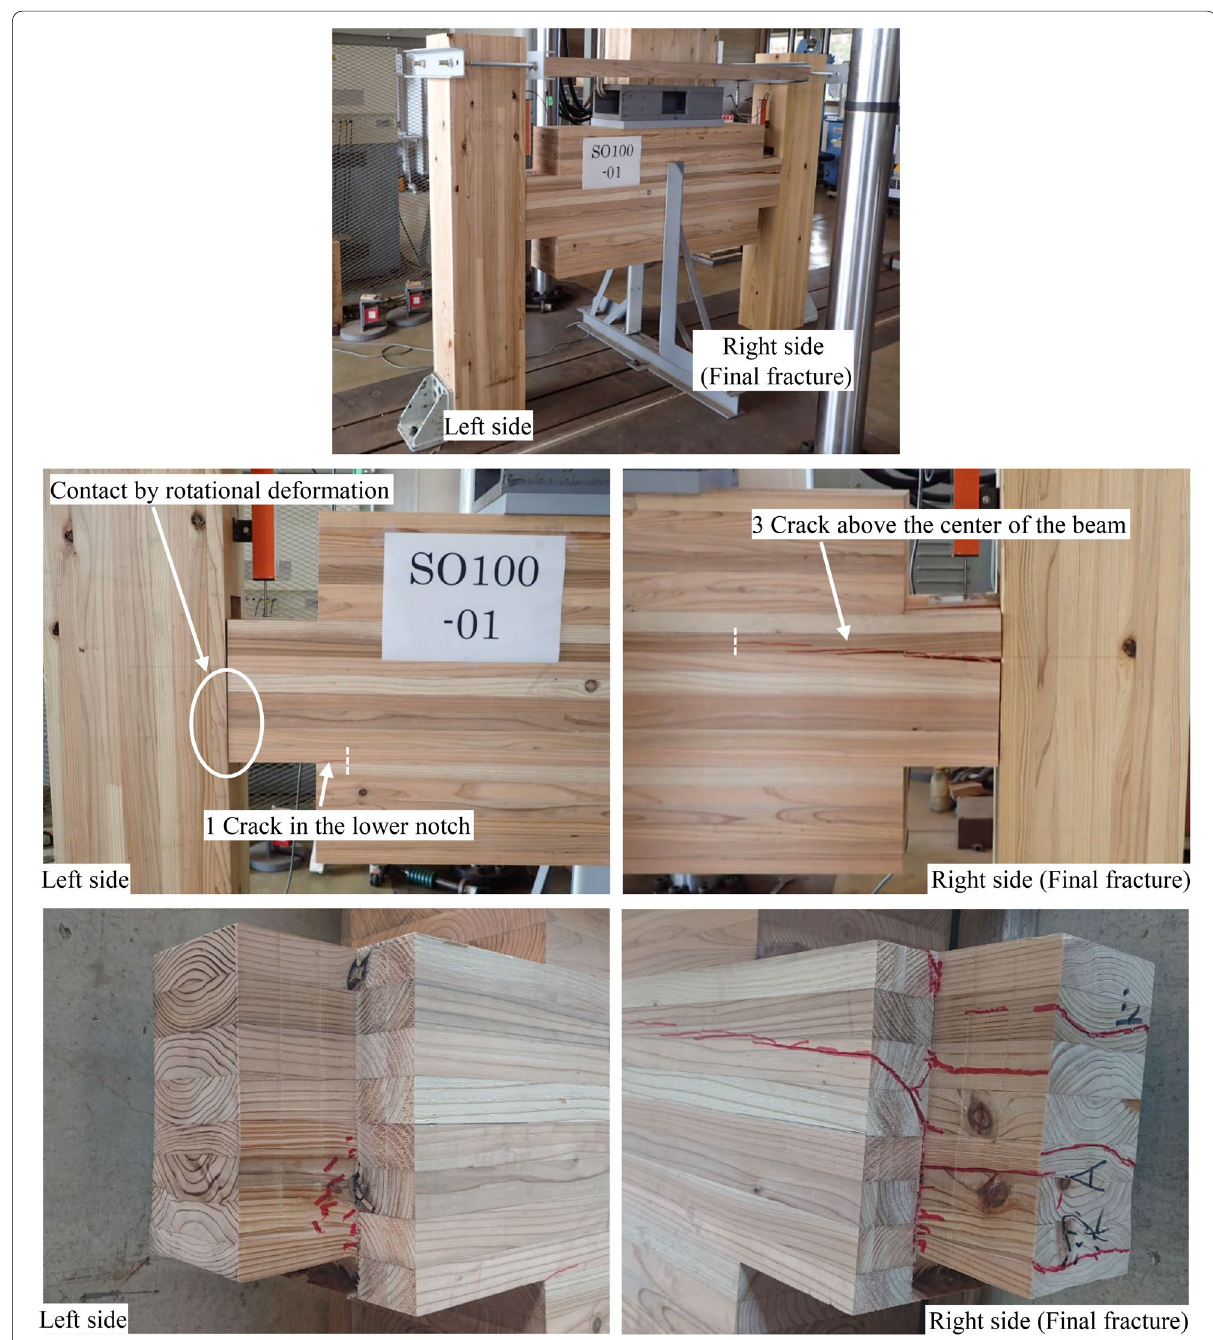
Fig. 10 Final fracture state of the specimen (J-L100, No.